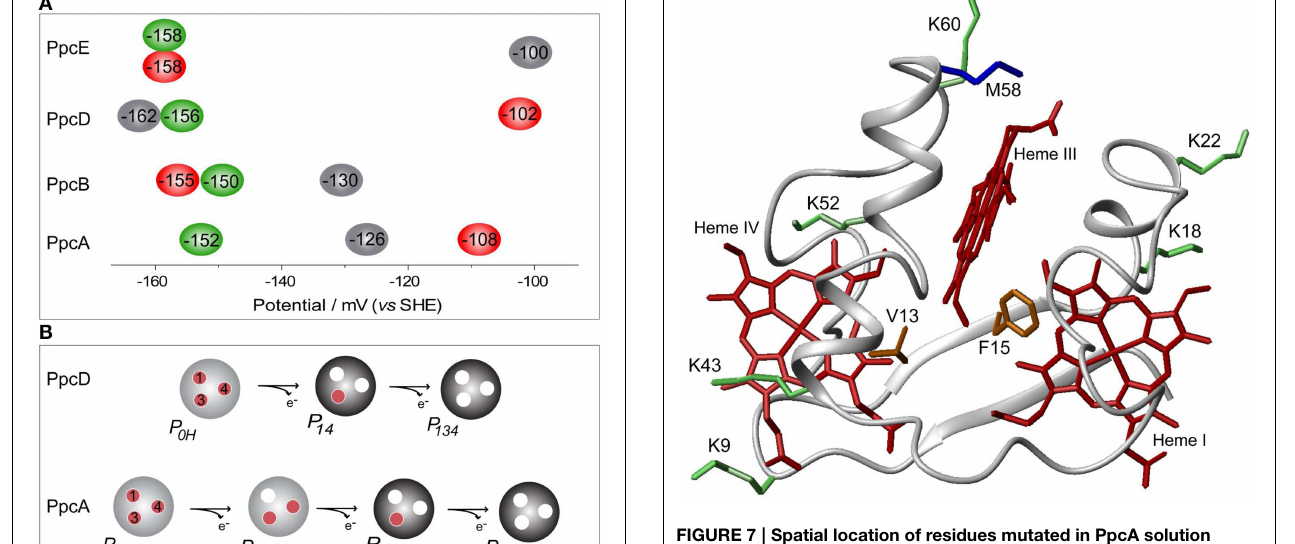
FIGURE 7 | Spatial location of residues mutated in PpcA solution structure (PDB code, 2LDO, Morgado et al., 2012b). The PpcA polypeptide chain (gray) is shown as C α ribbon and heme groups (red). The side-chain of K9, K18, K22, K43, K52, and K60 (green); V13 and F15 (orange); M58 (blue) are represented as stick